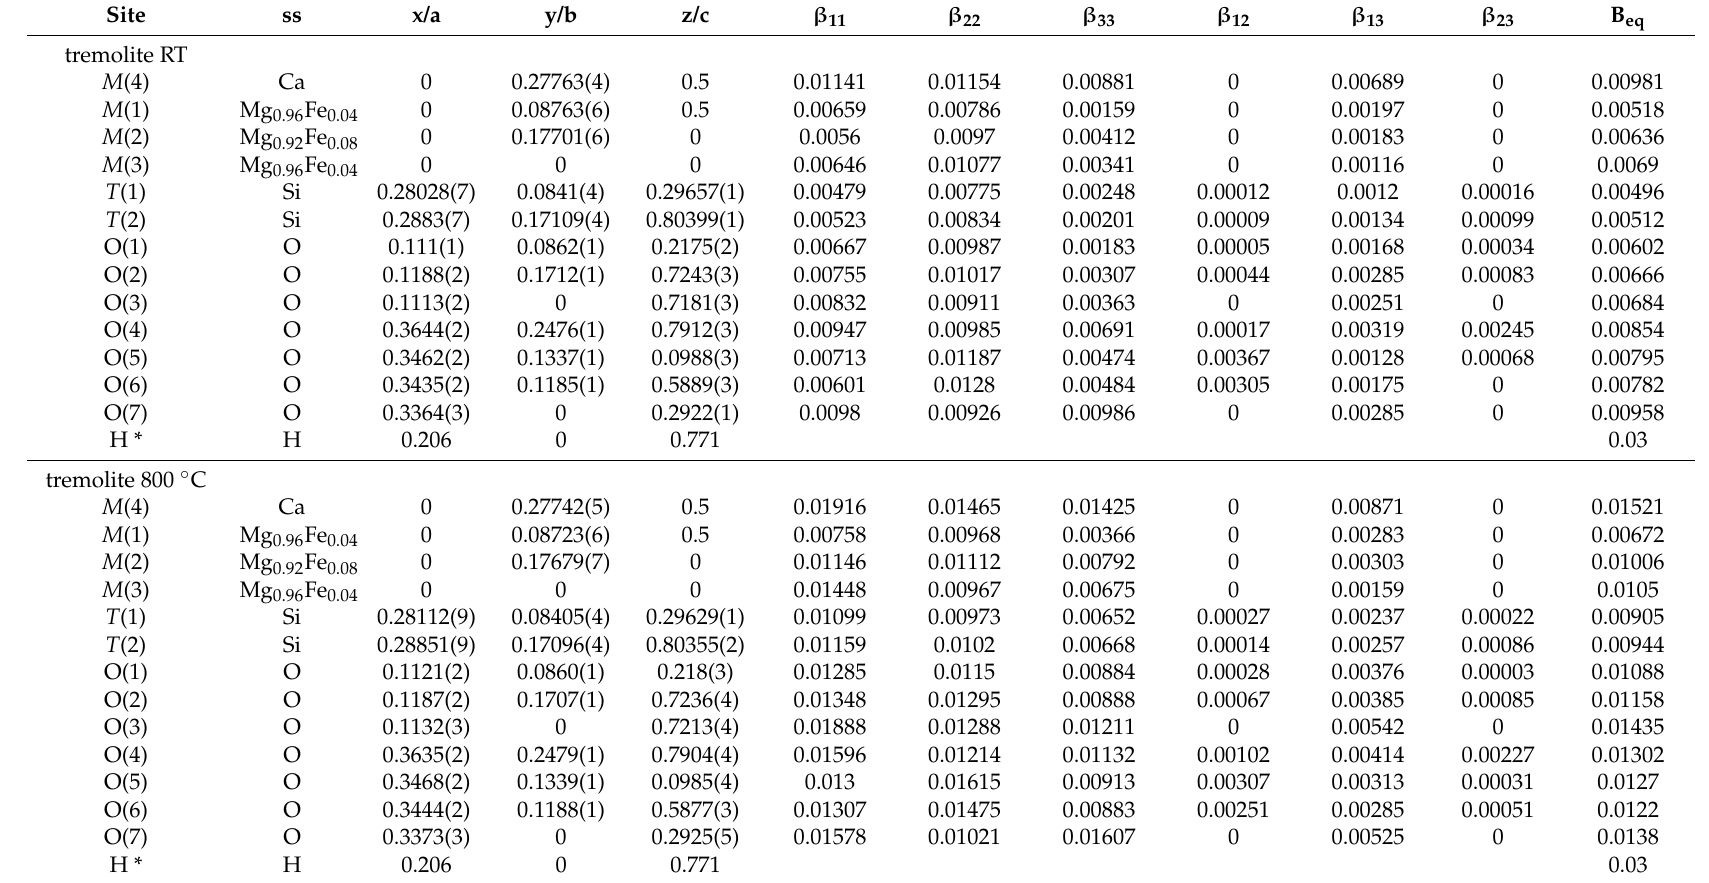
Table 3. Final atomic coordinates, occupancies, and atomic displacement parameters (Å 2 ). * Fixed values from